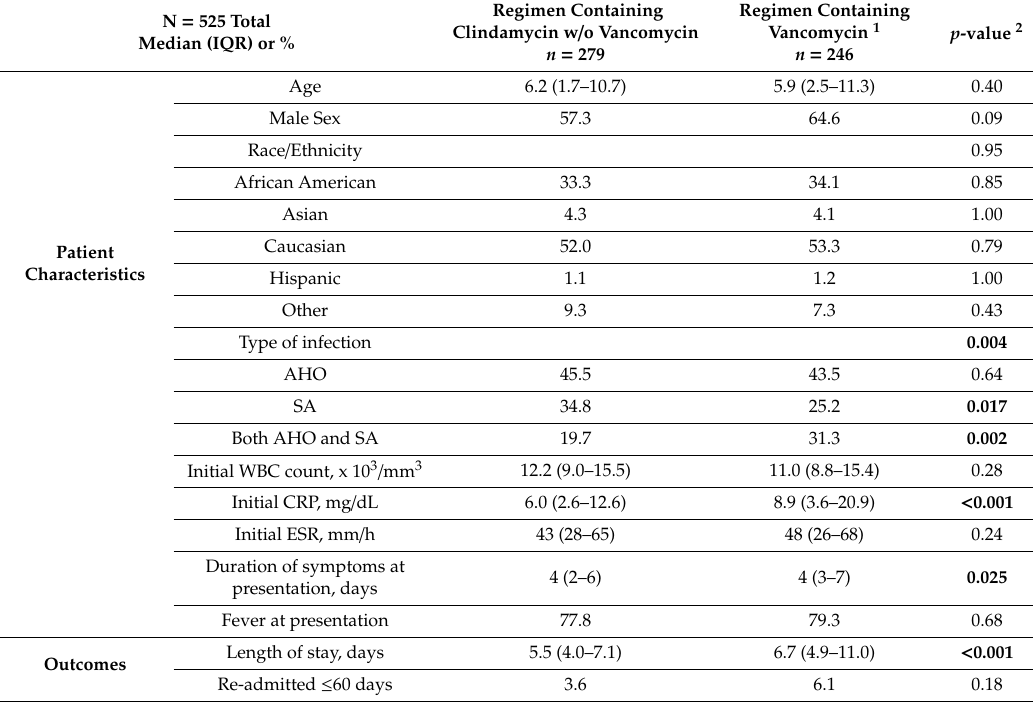
Table 4. Patient characteristics and outcomes based on initial antibiotic regimen.